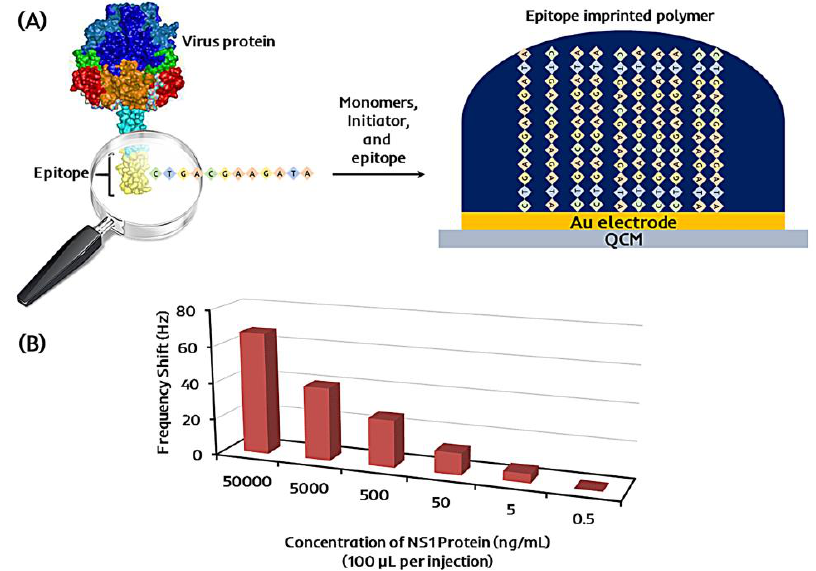
Figure 4. ( A ) A schematic representation of the epitope imprinting procedure; ( B ) The